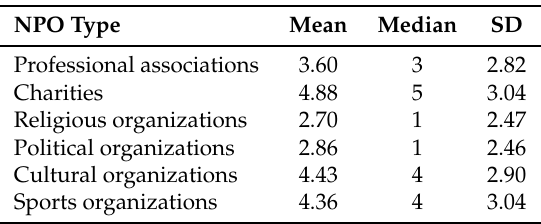
Table A5. Descriptives of interest in professional work.